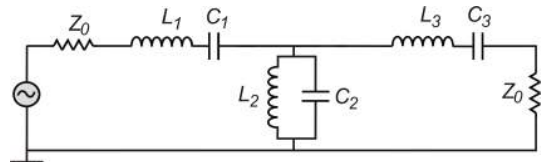
Figure 3: Equivalent circuit model of the conventionnel UWB parallel coupled bandpass